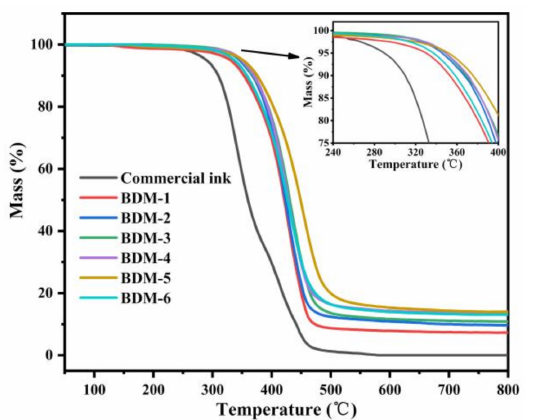
Figure 7. Thermogravimetric analysis (TGA) curves of samples 3D-printed with commercial and BDM